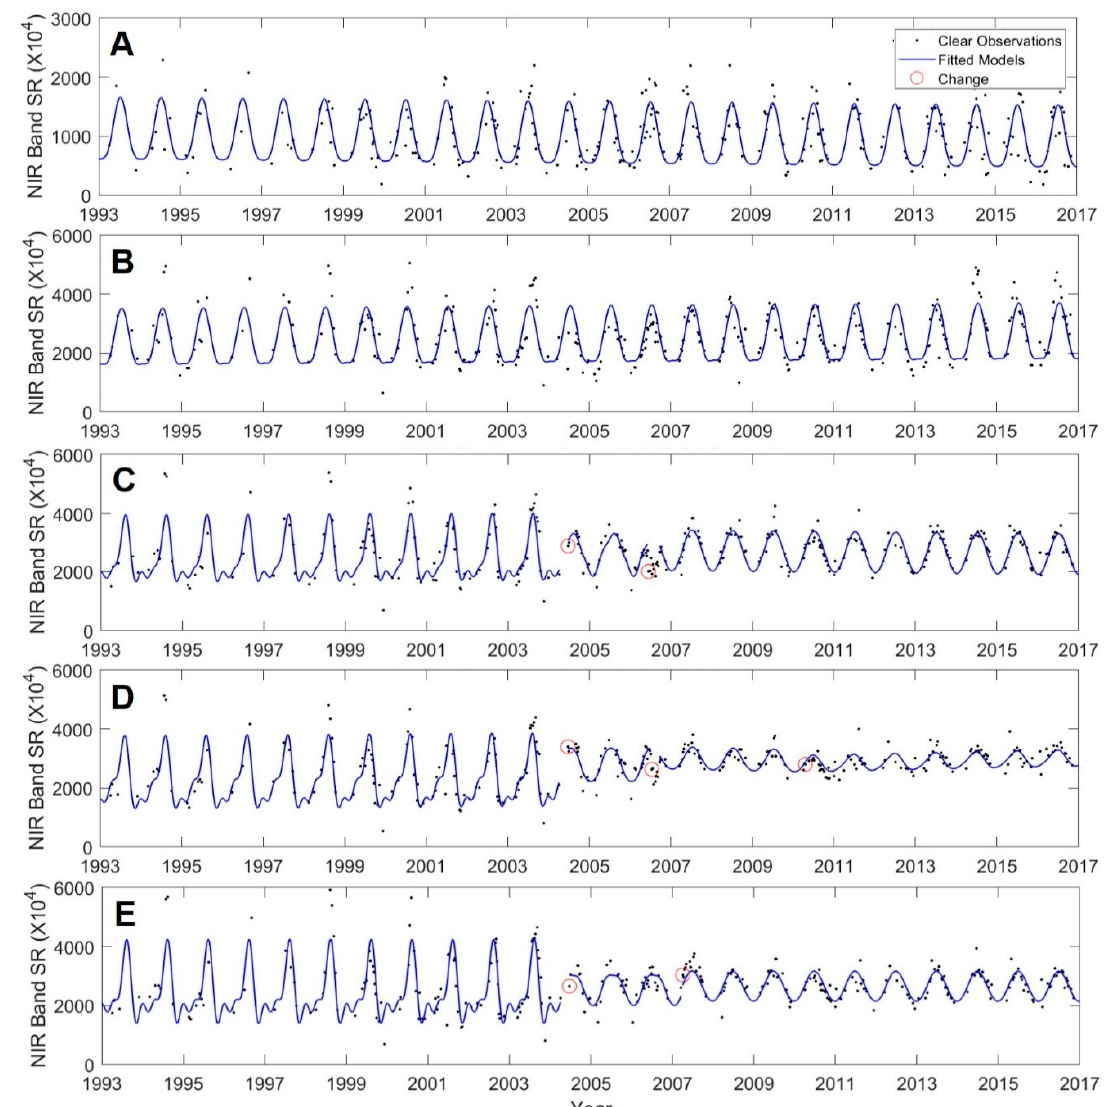
Figure 7. LULC change occurred to the select pixels identified in Figure 6 ~2004, as indicated by the break in the CCDC-fitted RIRLS models, ( A ) water body (no change indicated), (B) crops (no change indicated), ( C ) LULC change (from crop to developed class), ( D ) LULC change (from crop to developed class), ( E ) LULC change (from crops to grassland). The panels in Figure 7 align with the five points (A–E) given in Figure 6.